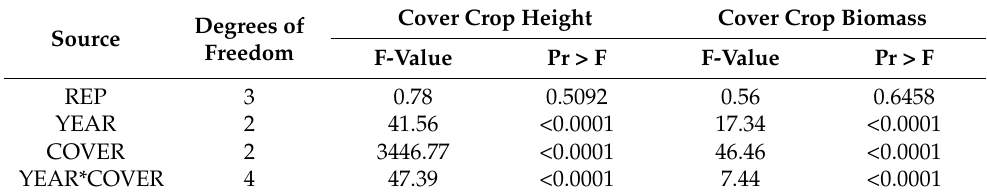
Table 2. Analysis of variance results for cover crops length and biomass.